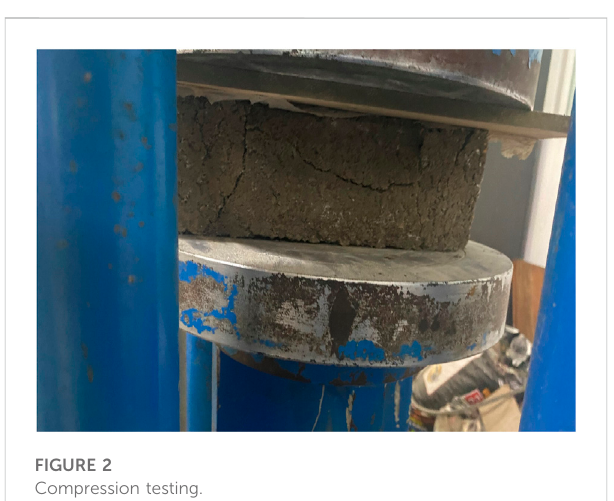
40:60, as listed in Table 3 and represented in Figure 3. Results